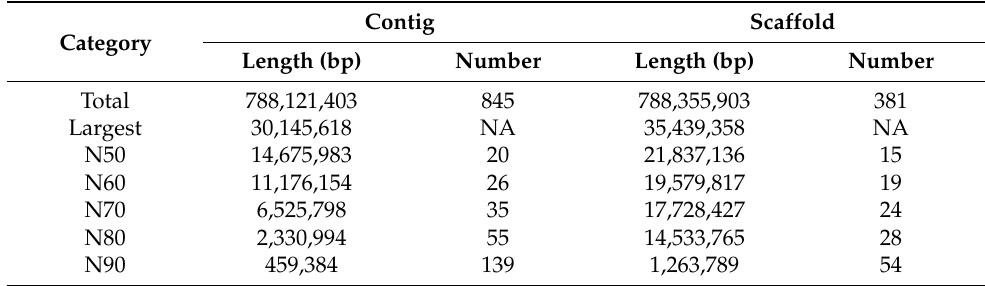
Table 2. Summary of the final striped catfish genome assembly.